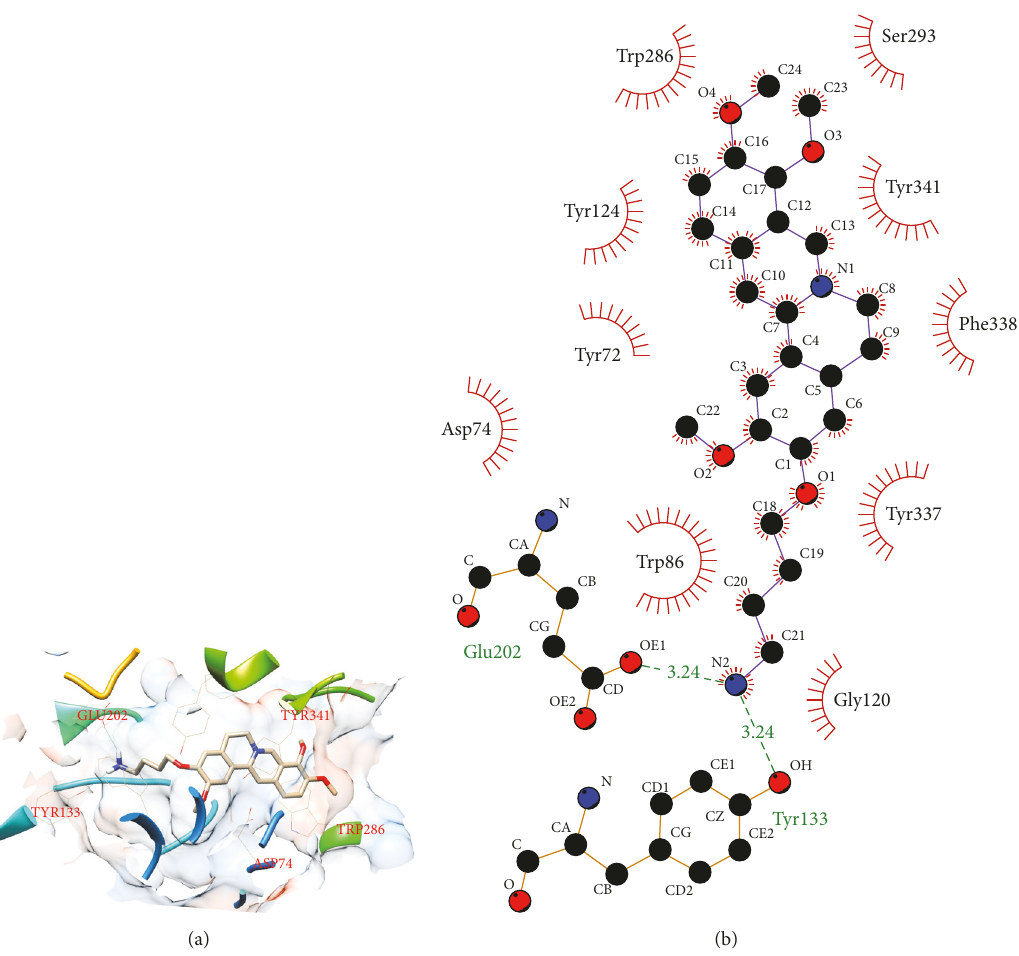
Figure 2: Docking models of the compound-enzyme complex. (a) Stereoviews looking down the gorge of TcAChE binding with 3g ; (b) representation of compound 3g docked into the binding site of AChE highlighting the protein residues that form the main interactions with the inhibitor. Hydrogen-bonding interaction between ligand and residues Tyr133 and Glu202 is shown with the green line. The residues of TcAChE involved in hydrogen-bonding and hydrophobic interactions with molecule 3g were analyzed using Chimera 1.9 [13] and Ligplot +